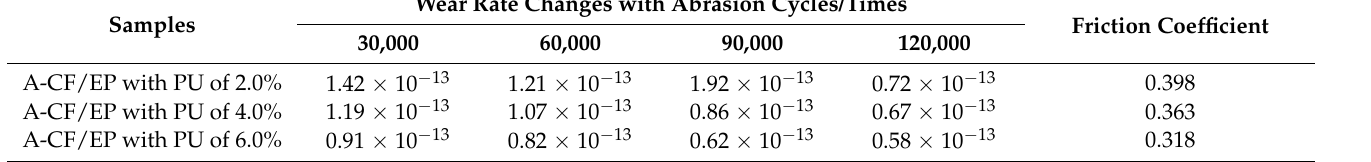
Table 2. Wear rates (10 − 13 · m 3 · N − 1 · m − 1 ) and friction coefficients of the M-CF/EP composites